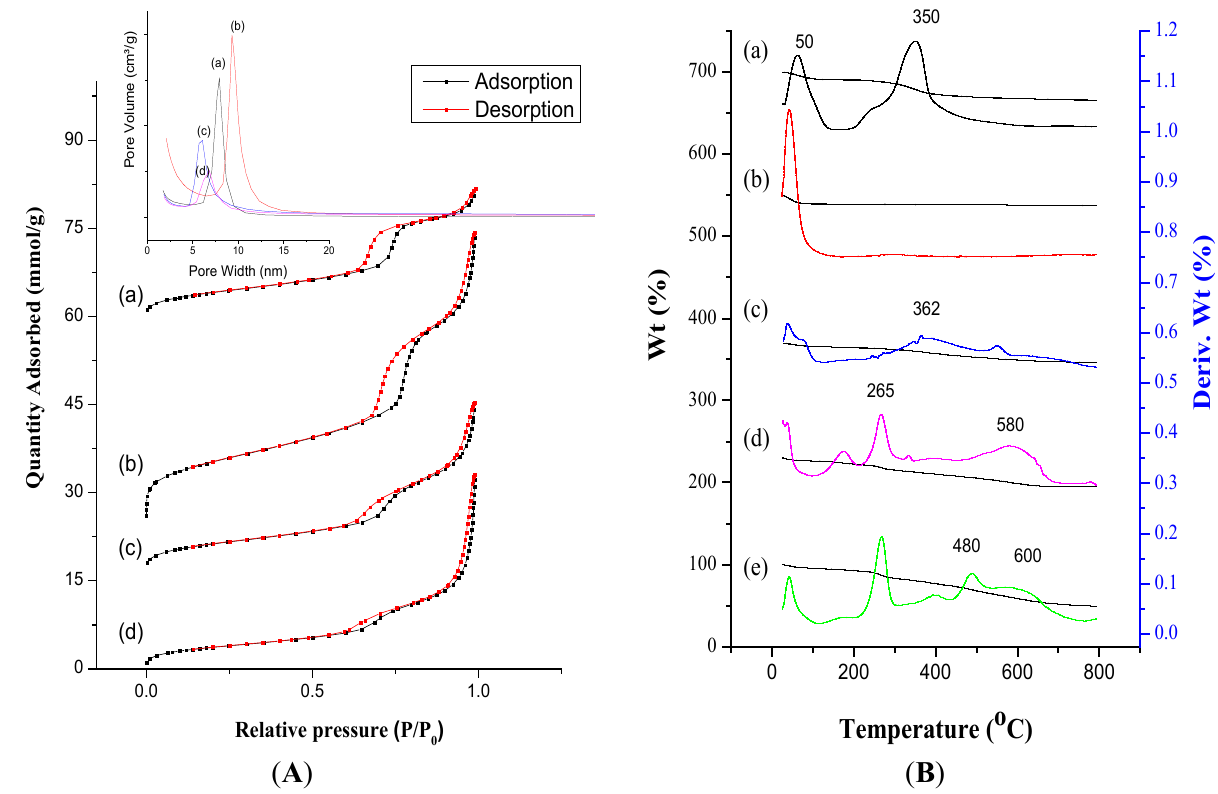
Figure 3. ( A ) Nitrogen adsorption–desorption isotherms of ( a ) as-synthesized IBN-4, ( b ) IBN-4 extracted, ( c ) IBN-4-NH 2 and ( d ) IBN-4-HRP. Corresponding pore size distribution plots are shown in the inset figure. ( B ) Thermogravimetric analysis curves of ( a ) as-synthesized IBN-4; ( b ) IBN-4 extracted, ( c ) IBN-4-NH 2 , ( d ) IBN-4-NH-GA and ( e )